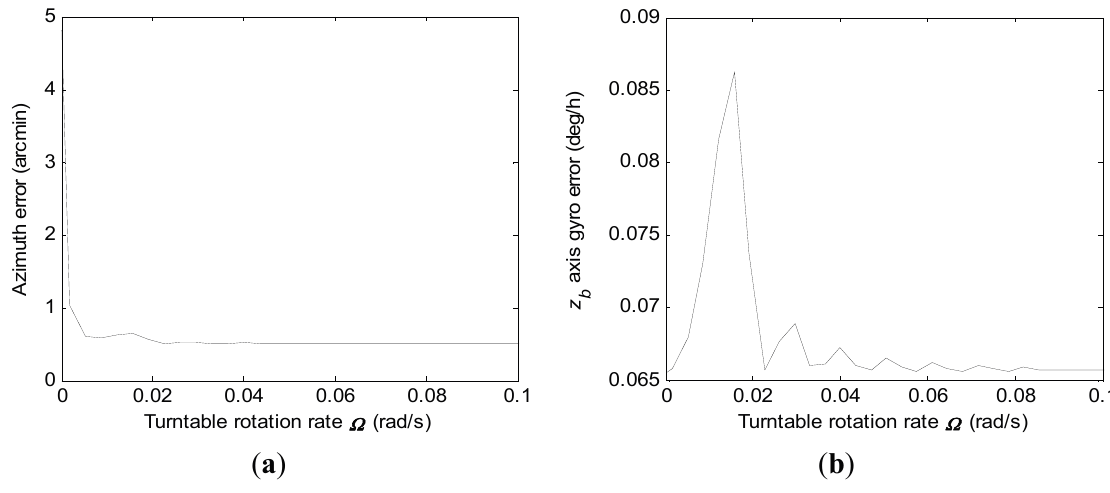
Figure 5 . 1- σ values of final azimuth error and final z b axis gyro error at 600 s computed according to turntable rotation rates ranging from 0.0003 rad/s to 0.1 rad/s when using the conventional KF scheme. ( a ) Azimuth error; ( b ) z b axis gyro